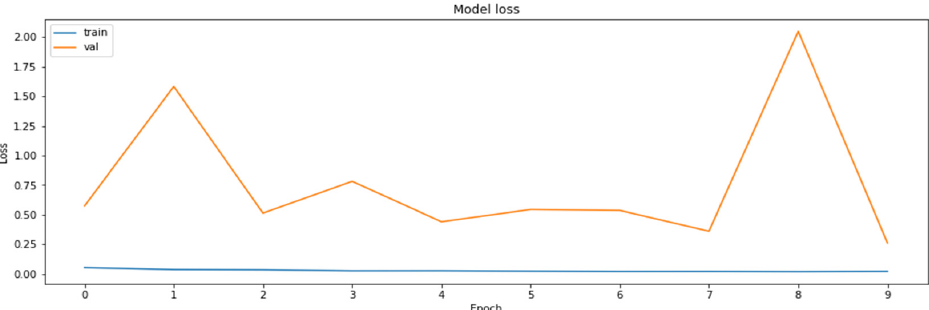
Figure 5. The loss function values on the training and the validation datasets obtained during the training with the application of the QAT method.